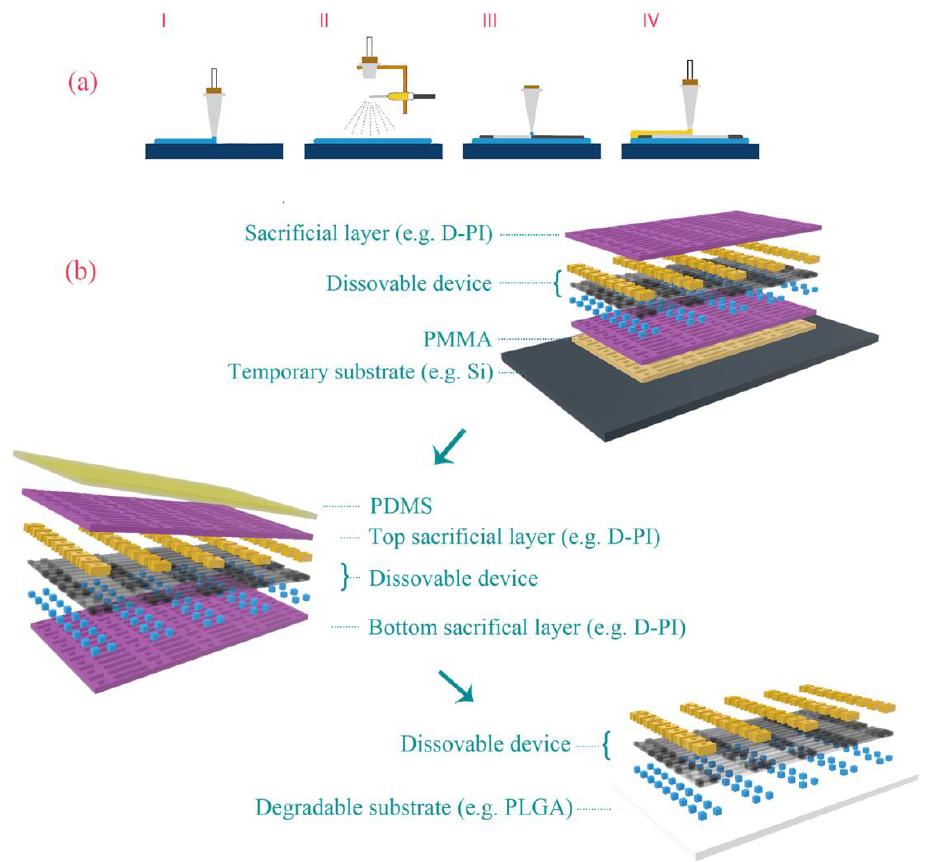
Figure 1. ( a ) Printing schematic diagram: (I) printing a base elastomer layer, (II) spray printing liquid metal materials, (III) activating selectively the electrical path, and (IV) printing of an encapsulation elastomer. Reproduced with permission from [69], Copyright WILEY-VCH Verlag GmbH & Co. KGaA, Weinheim, 2017. ( b ) Scheme of the key process for transfer printing a transient device from a temporary substrate (such as Si) to a degradable substrate (such as poly lacticco-glycolic acid (PLGA)). Reproduced with permission from [9], Copyright WILEY-VCH Verlag GmbH & Co. KGaA, Weinheim, 2014.